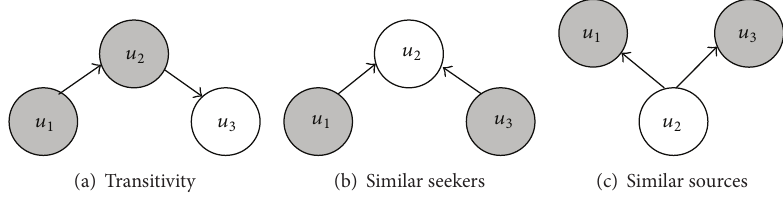
Figure 2: Structural